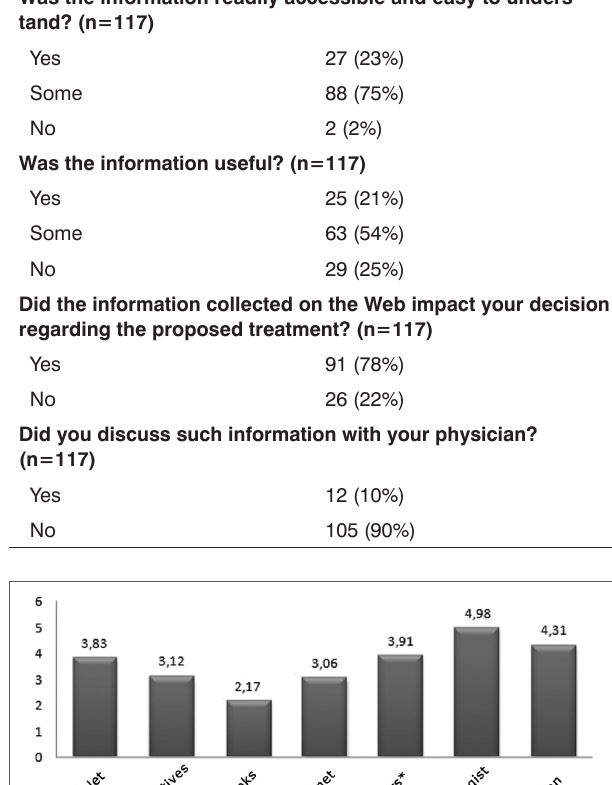
Table 1. Demographic data (n=132) Surgery performed on patients Adenotonsillectomy